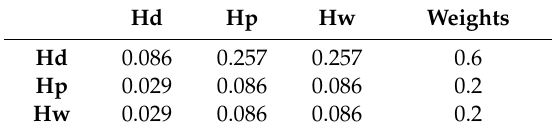
Table 13. Normalized comparison matrix of the criteria for the determination of the integrated hazard. Hd Hp Hw Weights